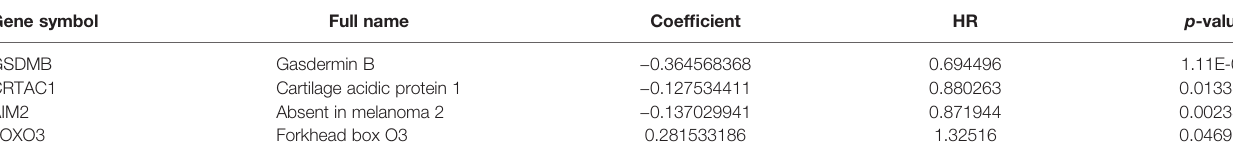
TABLE 1 | Genes included in prognostic gene